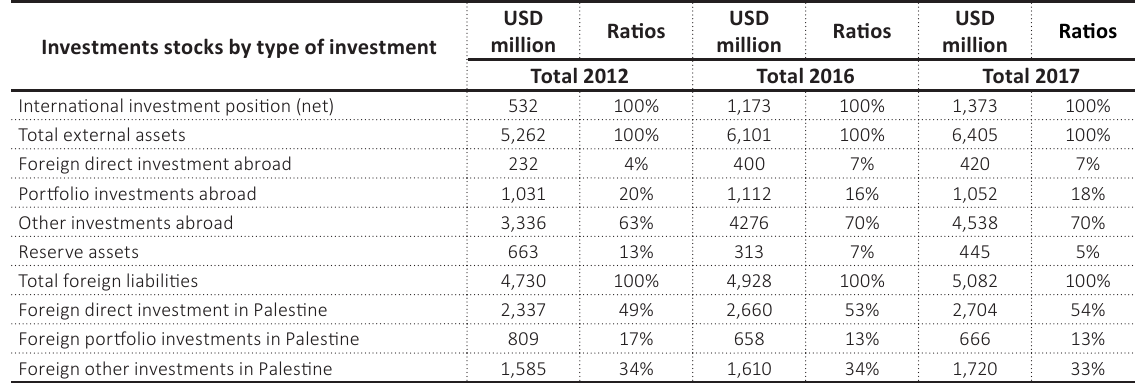
Table 3. International investment position in